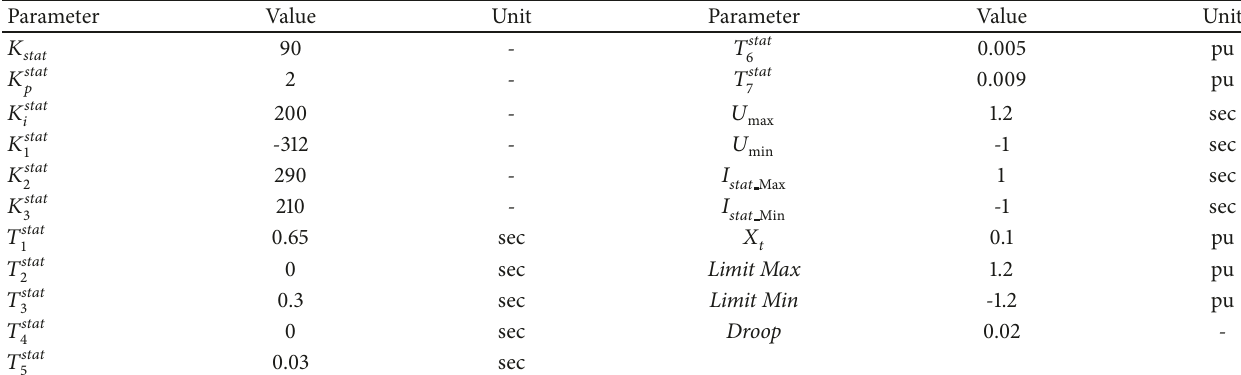
Table 3: The parameters of STATCOM control